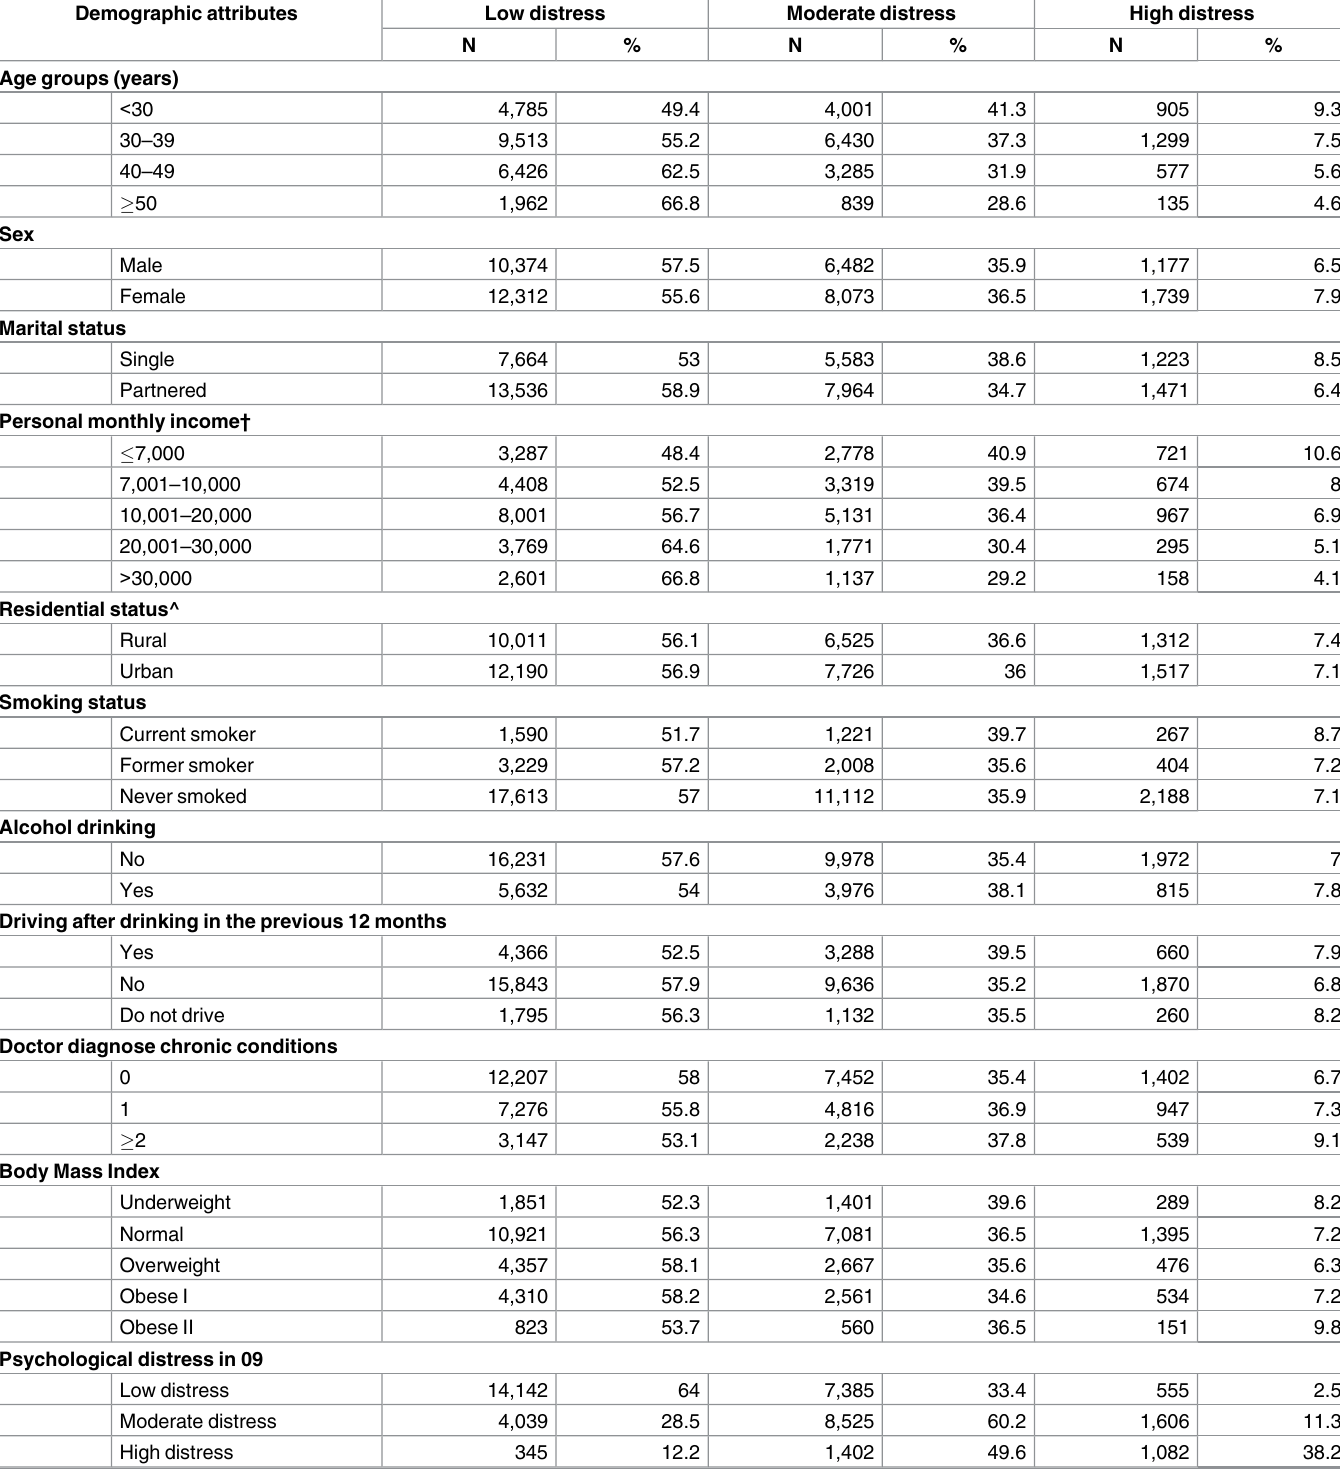
Table 1. Demographic and behavioural characteristics of Thai Cohort Study members in 2009, stratified by level of psychological distress in 2013 (N = 40,157). Demographic attributes Low distress Moderate distress High